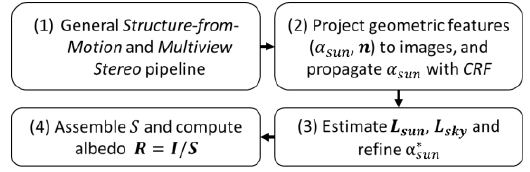
Figure 4. The workflow of our intrinsic image decomposition.